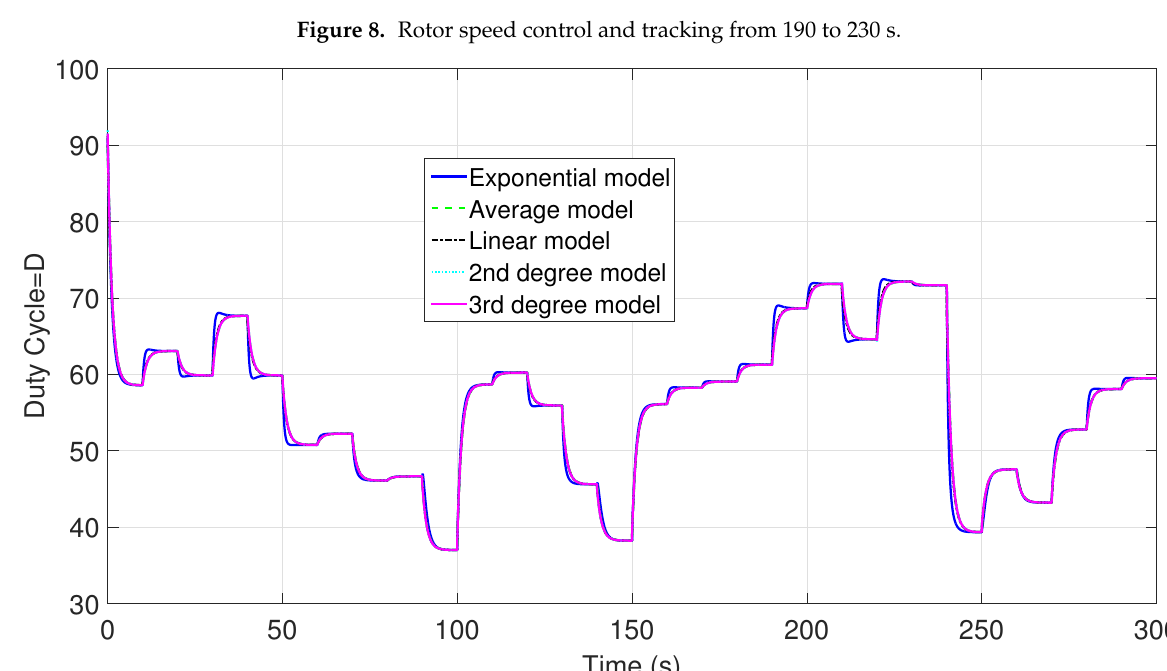
Figure 9. Whole span duty cycle for the proposed